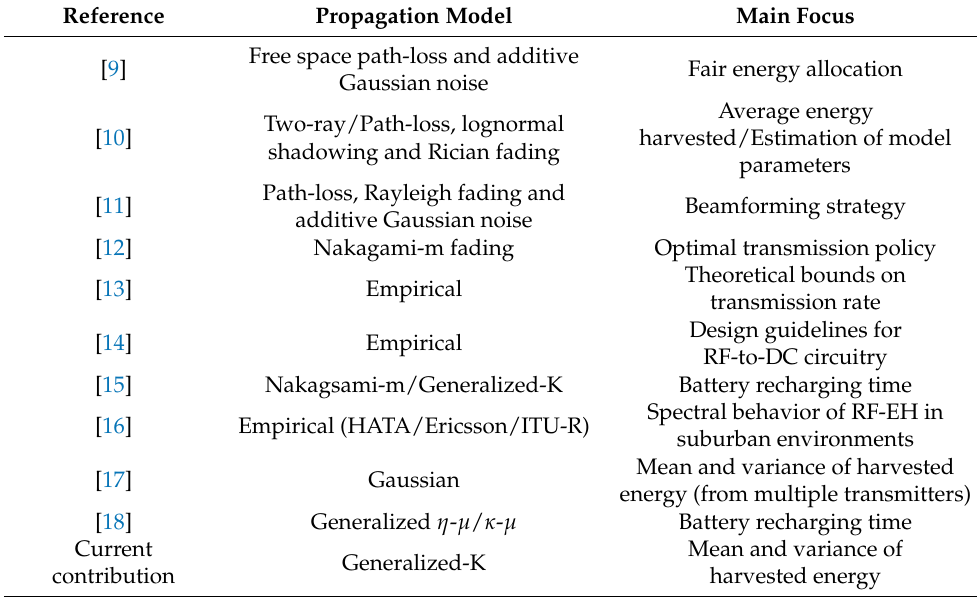
Table 1. Current state-of-the-art work in RF-EH involving channel propagation